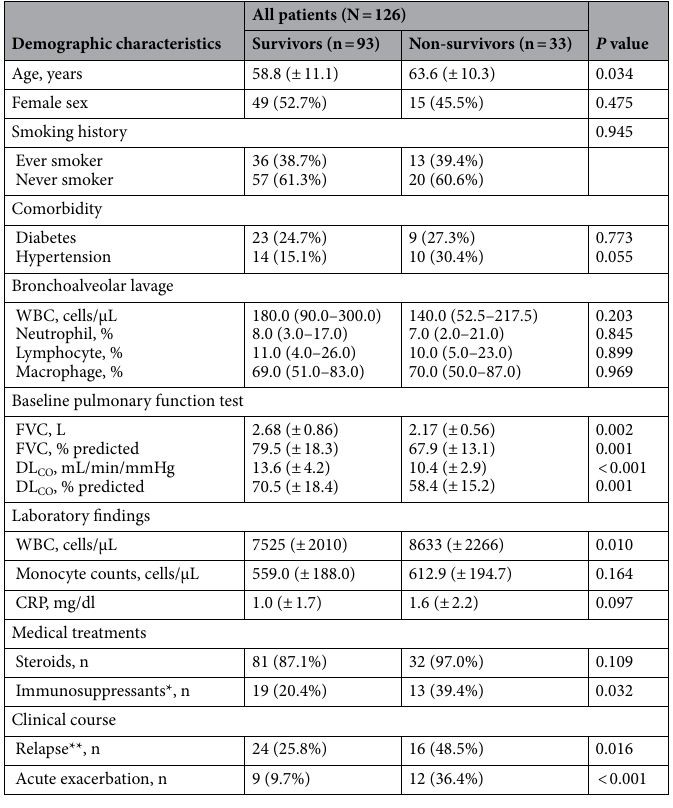
Lung function changes according to monocyte count. The average lung function change over 10 years was calculated using the regression analysis of the linear mixed-effect model after adjusting for age, sex, and smoking history, and it was found that the annual decline of predicted FVC (mL) was -28.49 mL/year and − 65.76 mL/year in the low- and high-monocyte groups, respectively (Table 3). FVC (mL) ( P = 0.006) and FVC (% of predicted) ( P = 0.005) showed a significant interaction over time between the low- and high-monocyte groups (Fig. 1A, B). The annual decline of predicted DL CO (mL/min/mmHg) was − 0.26 mL/min/mmHg/year and − 0.40 mL/min/mmHg/year in the low- and high-monocyte groups, respectively. The predicted DL CO (% of predicted) was − 0.73%/year and − 1.16%/year in the low- and high-monocyte groups, respectively (Fig. 1C, D). However, there was no significant interaction over time for DL CO (mL/min/mmHg) ( P = 0.068) or DL CO (% of predicted) ( P = 0.144) (Table 3).